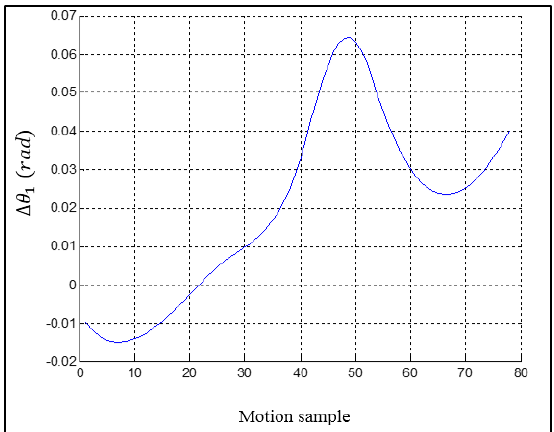
Fig. 16. The first and second angles of the two-link robot arm result for the D* based on PSO path for the second